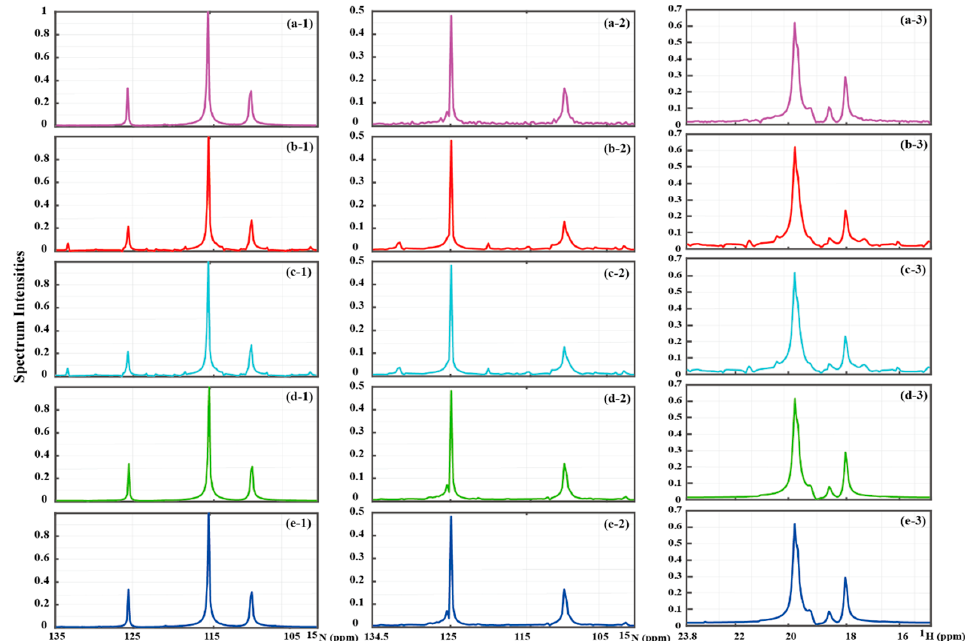
Figure 6. 1D traces of reconstructed 2D spectra ( a-1 )–( a-3 ) is the fully sampled spectrum of the 1D traces of HSQC spectra of GB1, the best-TROSY spectrum of ubiquitin, and solid NMR spectrum, respectively. ( b-1 )–( b-3 ), ( c-1 )–( c-3 ), ( d-1 )–( d-3 ), and ( e-1 )–( e-3 ) are reconstructed spectra using LRHM, LRHMF, SLS, and SLSMF, respectively. Note: ( a-1 )–( a-3 ) are fully sampled spectra of 1D traces, and their locations in the corresponding fully sampled spectrum are marked with a dotted line in Figures 3–5.